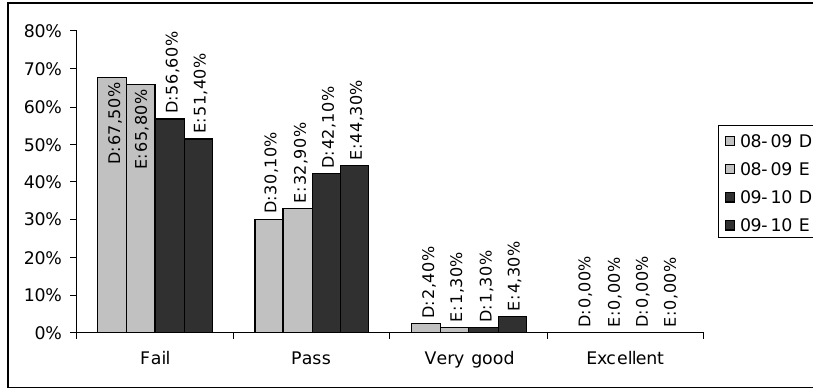
Figure 4. “Comparison of the results of the final theory exam of BLOCK III (groups D and E) for academic years 08-09 and 09-10”. Source: